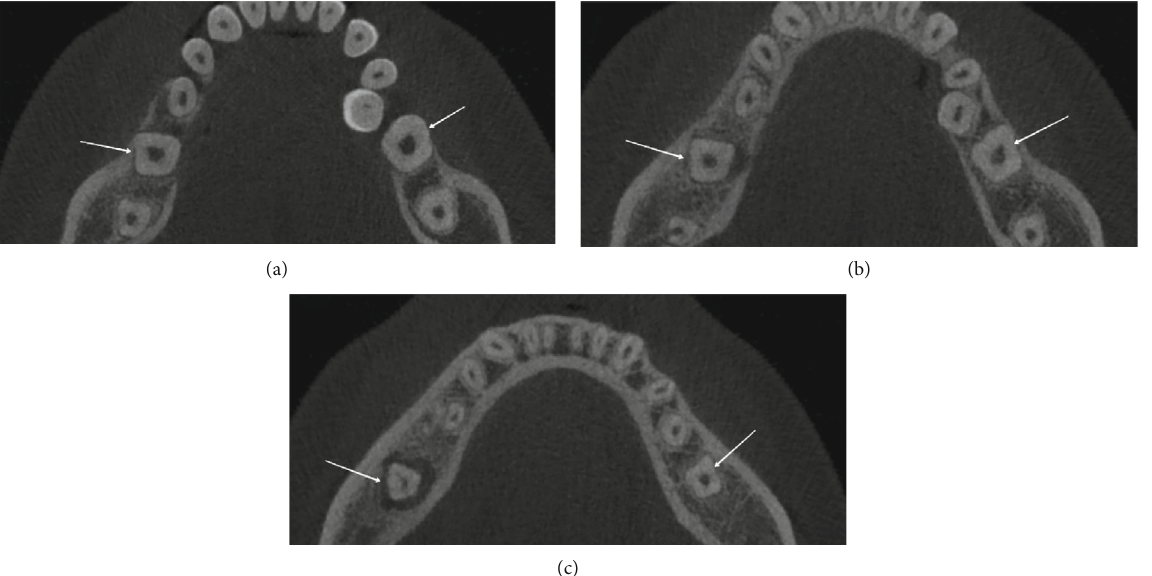
Figure 2: Axial section of CBCT scan showing the presence of a single canal in #36 and #46 at (a) cervical third, (b) middle third, and (c) apical